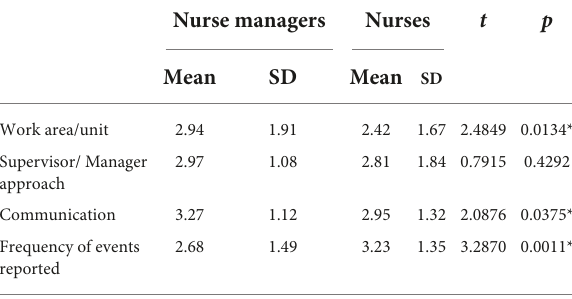
TABLE 3 Nurse managers’ and nurses’ perceptions of patients’ safety.